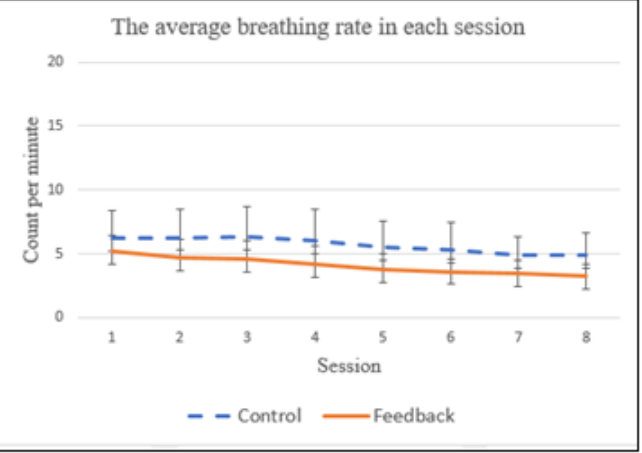
Figure 11. The average breathing rate in each session.